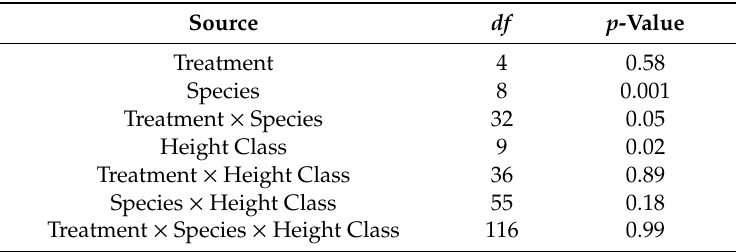
Table 3. ANOVA table of natural regeneration stem density inside clusters plantings for the five site preparation and release treatments tested in the shortleaf pine–hardwood establishment study, following four growing seasons in Morgan County, Tennessee, USA. Source df p